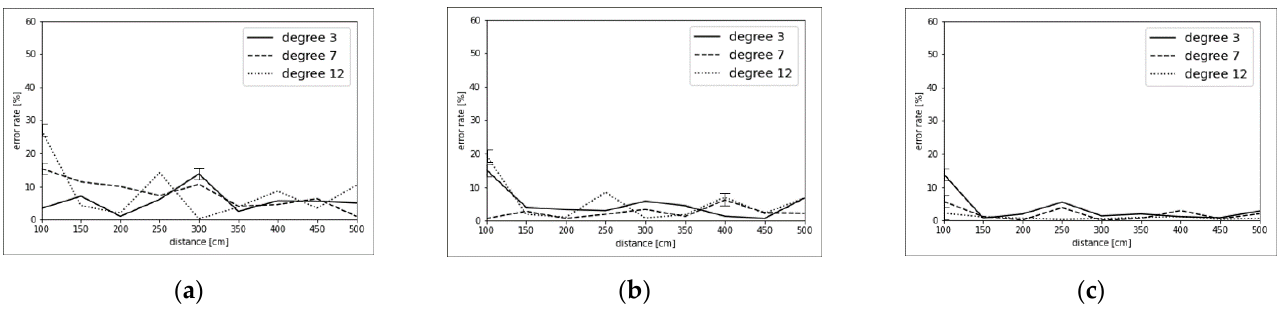
Figure 10. Test results with respect to varying baselines and angles at a height of 40 cm: ( a ) error rates corresponding to various angles and a baseline of 10 cm, ( b ) error rates corresponding to various angles and a baseline of 20 cm, ( c ) error rates corresponding to various angles and a baseline of 30 cm.